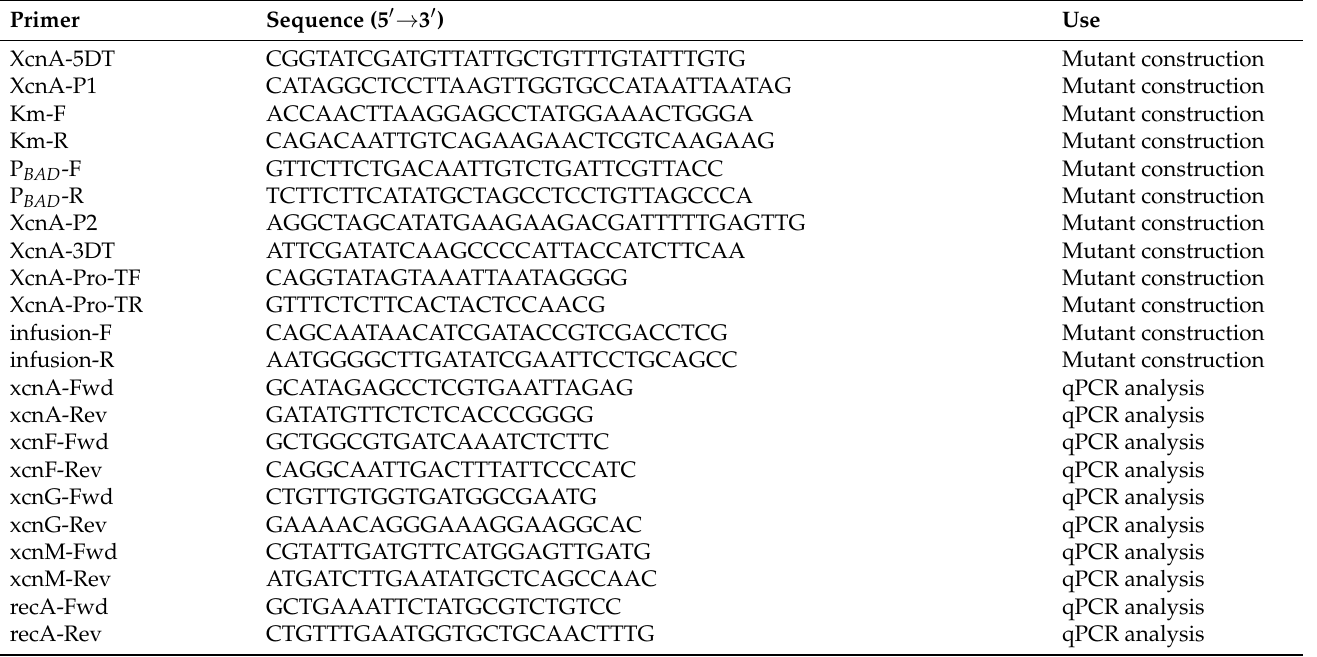
Table 2. Primers used in this